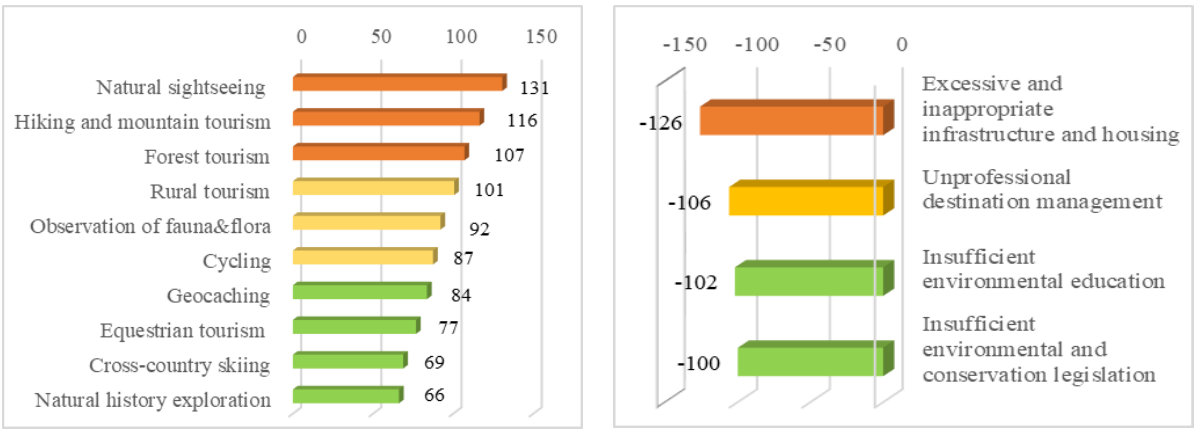
Fig. 4. Values of the degree of severity of attributes